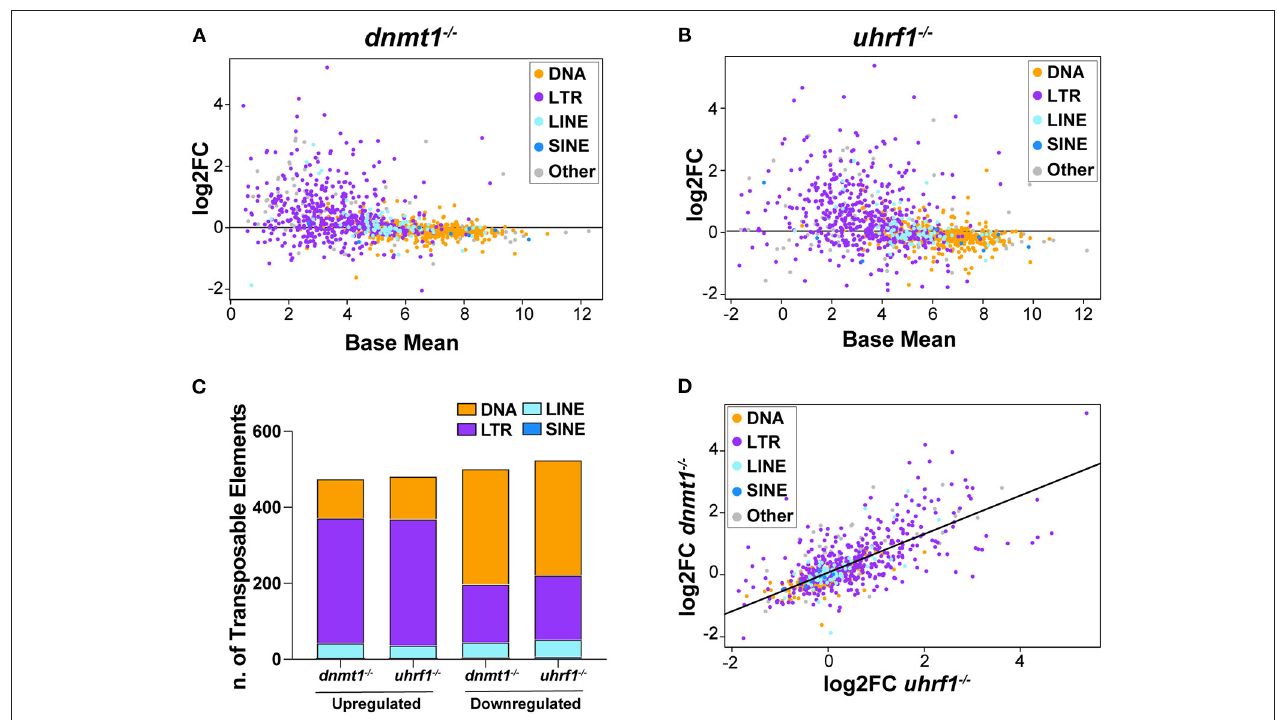
FIGURE 2 | dnmt1 and uhrf1 loss causes overexpression of retrotransposons. RNAseq analysis of Transposable Elements in uhrf1 − / − and dnmt1 − / − mutant livers. (A) MA plot showing log 2 fold change of repetitive elements in dnmt1 − / − livers calculated on WT siblings and Base Mean in WT siblings. Repetitive elements are divided by Class in DNA transposons (yellow), LTR (purple), LINE (light blue), SINE (blue), and other (gray). (B) MA plot showing log 2 fold change of repetitive elements in uhrf1 − / − livers calculated on WT siblings and Base Mean in WT siblings. Repetitive elements are divided by Class in DNA transposons (yellow), LTR (purple), LINE (light blue), SINE (blue), and other (gray). (C) Bar graph of Transposable Elements divided by class in uhrf1 − / − and dnmt1 − / − mutant livers. Upregulated TEs have log 2 fold change > 0 and downregulated TEs have log 2 fold change < 0. (D) Correlation plot of repetitive elements in uhrf1 − / − and dnmt1 − / − mutant livers. Upregulated TEs have adj as pedix < 0.05 and log 2 fold change > 0; downregulated TEs have p adj < 0.05 and log 2 fold change < 0. Log 2 fold change is calculated between mutants and their own WT siblings.